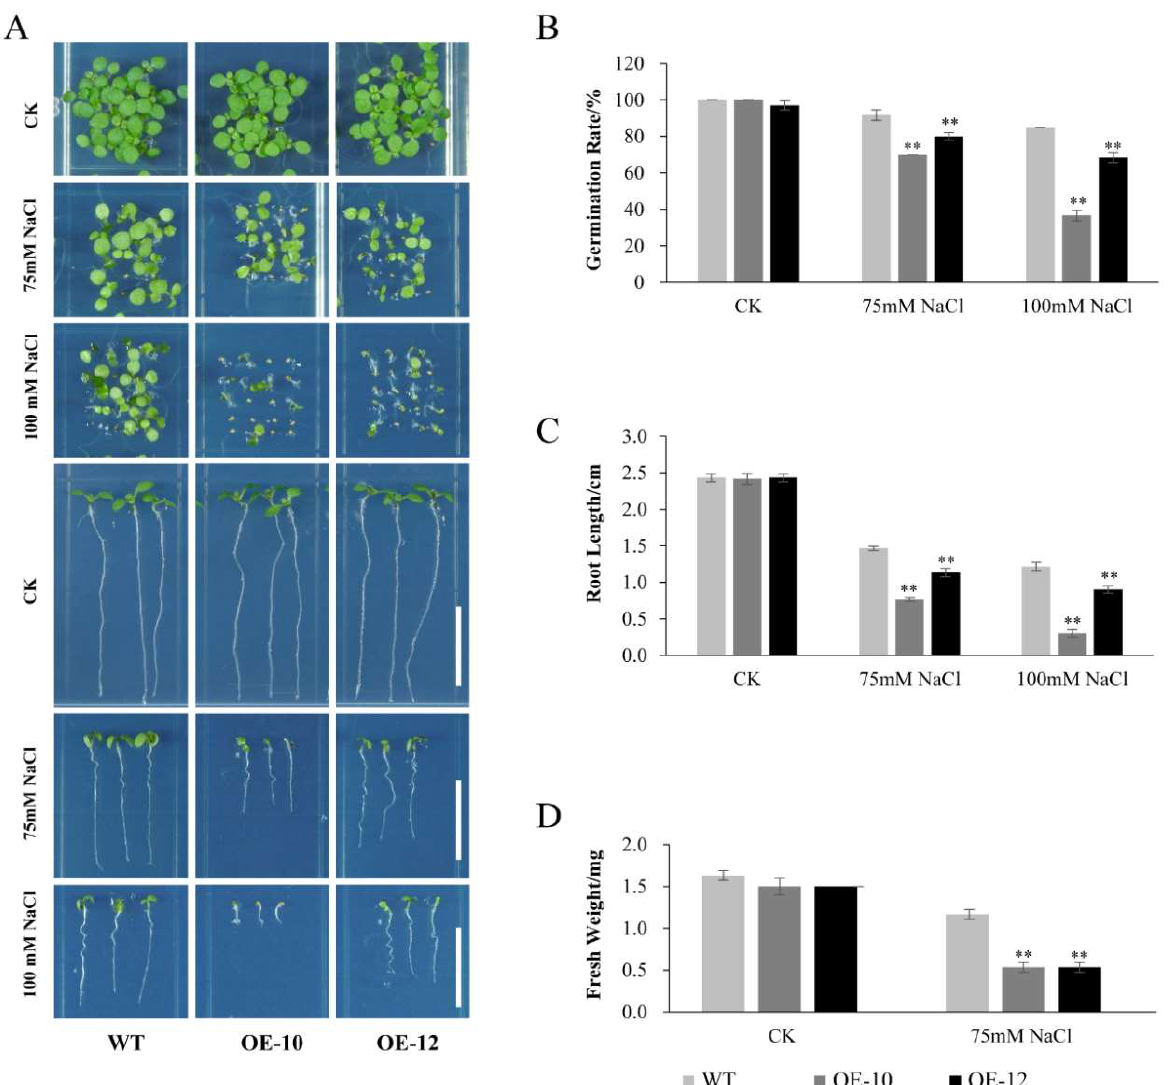
Figure 8. Phenotypic analysis of AcWRKY31 overexpression Arabidopsis plants in response to salt stress. ( A ) Performance of WT and AcWRKY31 overexpression Arabidopsis plants with or without salt treatment for 7 days; scale bar = 1 cm. The germination rate ( B ), root length ( C ) and fresh weight ( D ) of all lines in ( A ). Error bars indicate ± SD of three biological replicates. Asterisks indicate significant differences between the WT and the AcWRKY31 overexpression lines evaluated with Student’s t test (** p < 0.01).